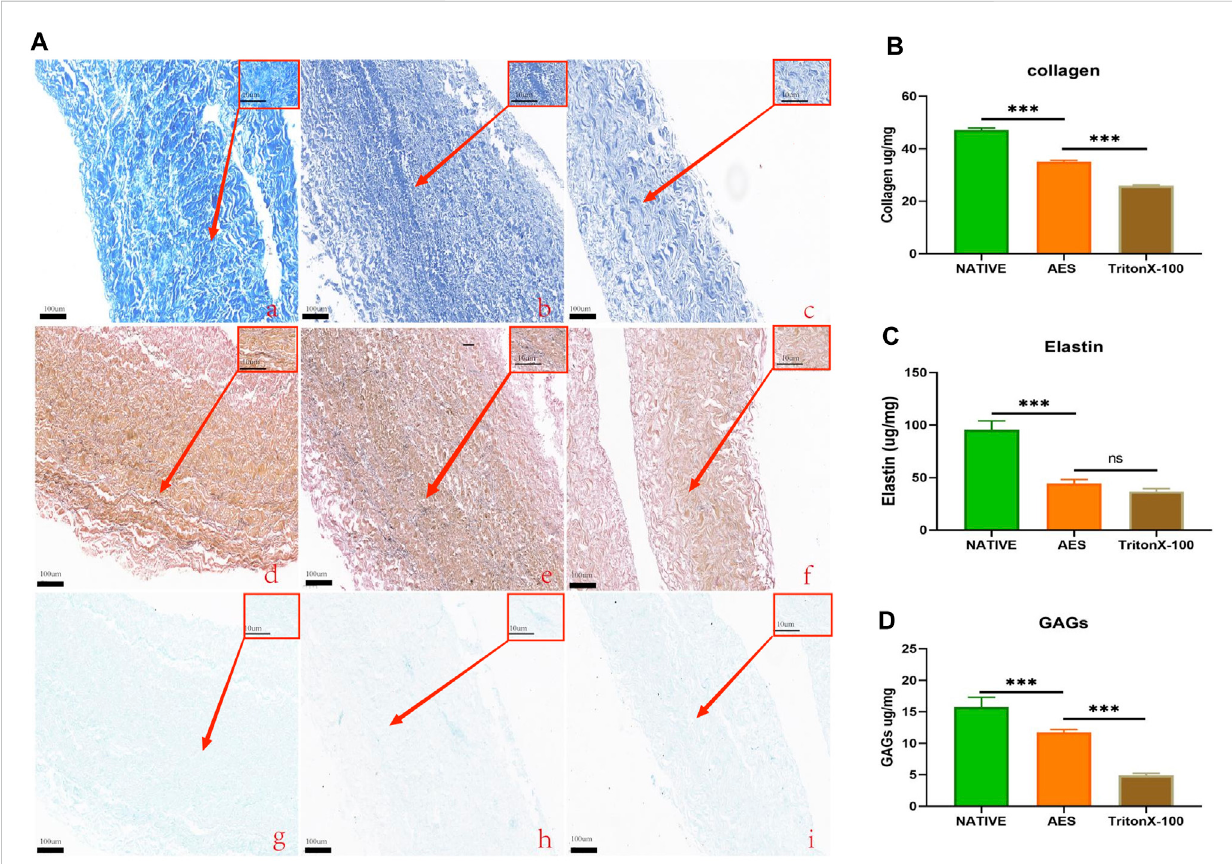
FIGURE 2 (A) Characteristicsextracellularmatrixaftertreatment.MASSONstaining: (Aa) ,Native; (Ab) ,AES; (Ac) ,triton;EVGstaining: (Ad) ,native; (Ae) ,AES; (Af) , triton;Alcianbluestaining: (Ag) ,native; (Ah) ,AES; (Ai) ,triton;Lowmagni fi cation(×10);(rectangularbox)Highmagni fi cation(×100).Evaluationofcollagen (B) , elastin (C) and GAGs (D) content of ECM (n = 6; * p < 0.05; ** p < 0.01; *** p < 0.001; ns represents no signi fi cant